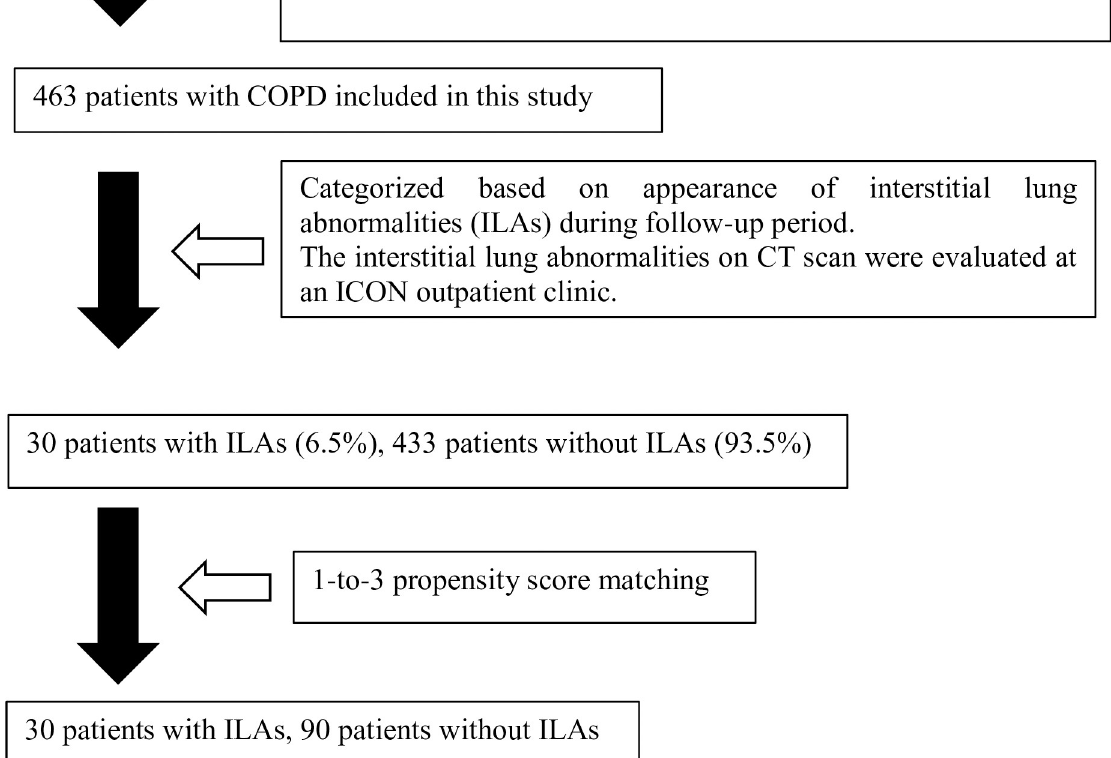
Fig 2. We conducted a cross-sectional study to analyze data prospectively collected from consecutive scheduled visits or newly registered patients in the Ishinomaki COPD Network (ICON) registry between April 2012 and November 2018.